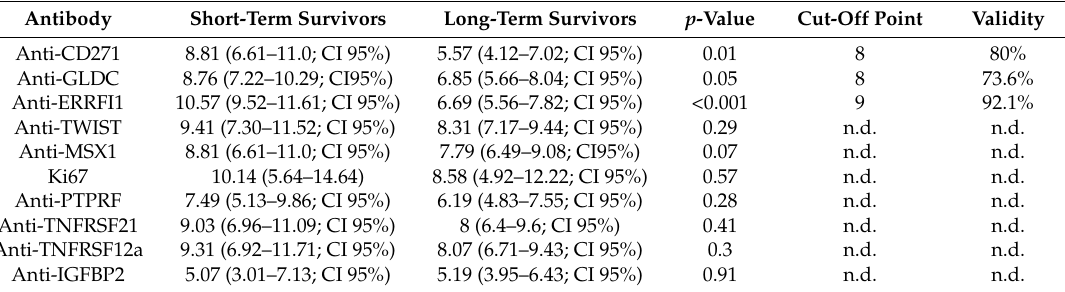
Table 2. Data comparison of short-term survivors vs. long-term